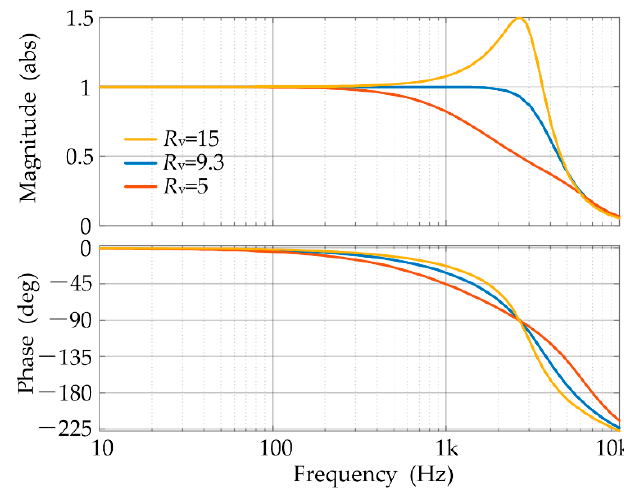
Figure 4. Bode plot of G ad